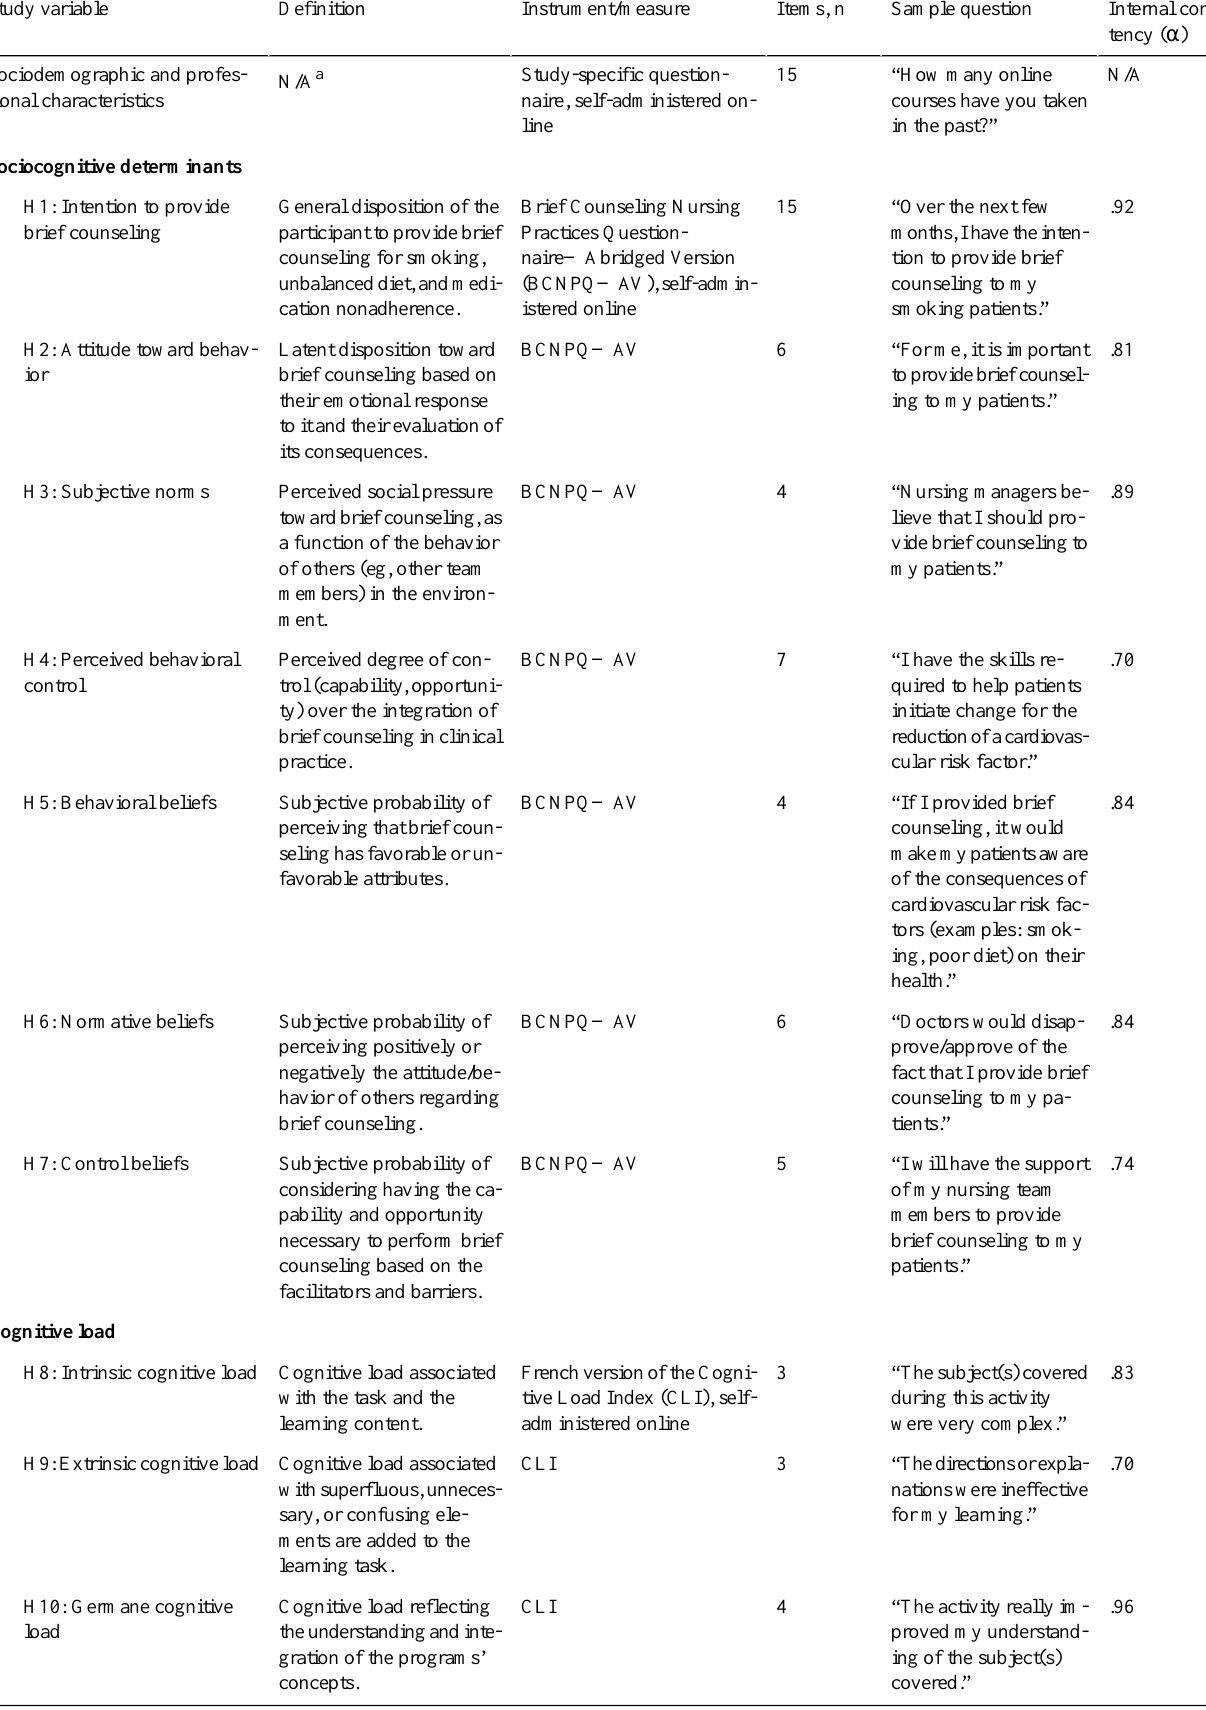
Table 2. Study variables and